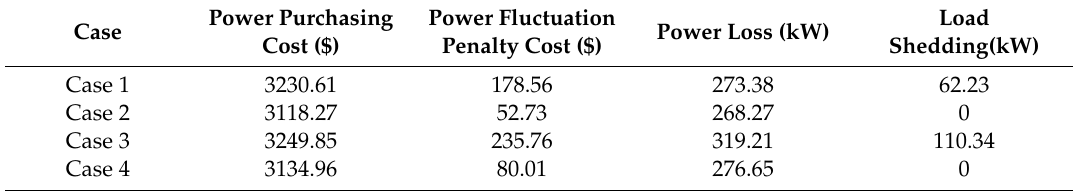
Table 7. Simulation results for di ff erent